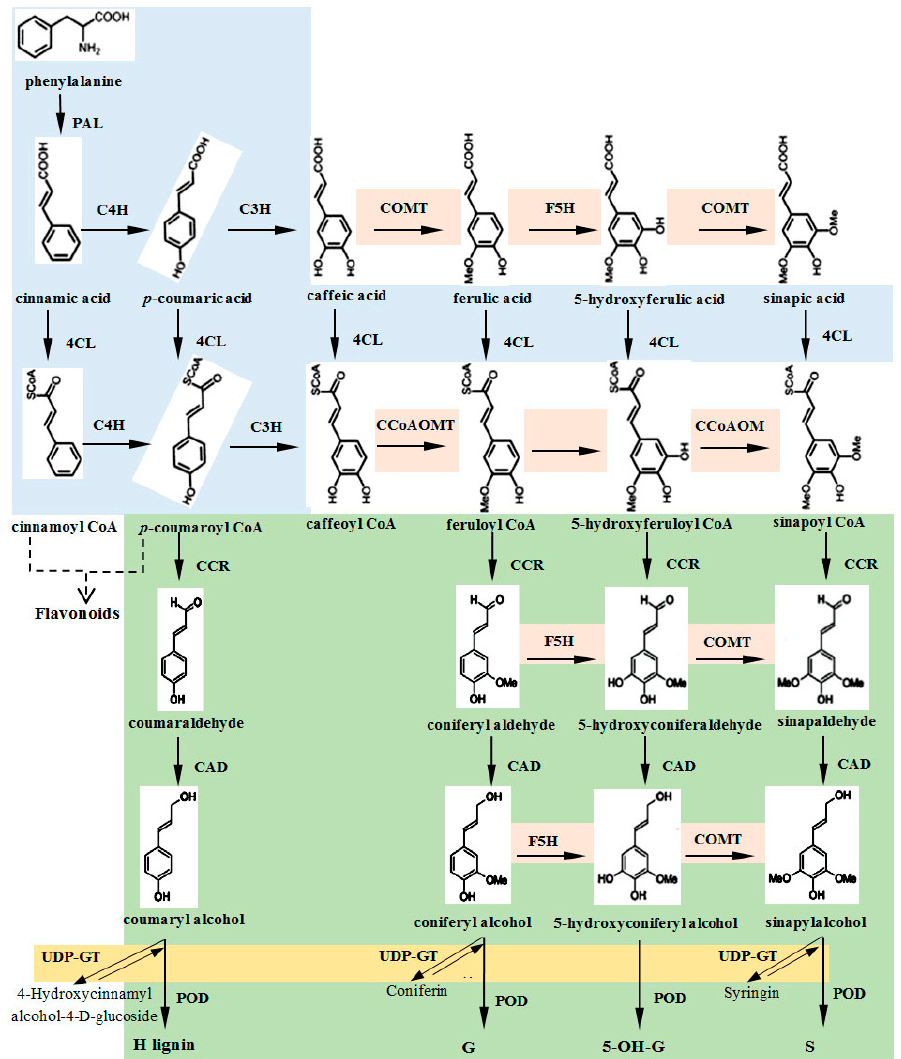
Figure 1. Phenylpropanoid pathway leading to lignin synthesis was obtained from the KEGG database of ramie [27]. Blue indicates the phenylpropanoid pathway; orange indicates the lignin-specific synthetic pathway; green indicates the downstream pathway of lignin synthesis; gold indicates the shunt pathway of lignin monomer synthesis.